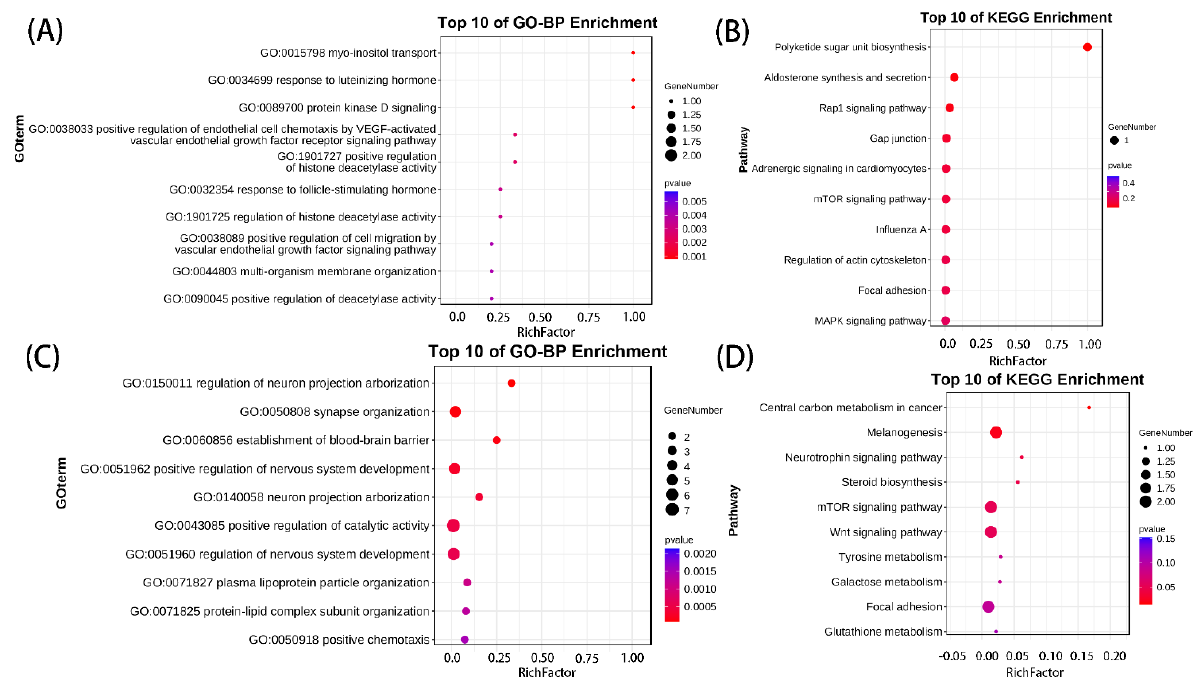
Figure 4. Functional enrichment analysis on DEcirc/miRNAs-DEmRNAs overlapping genes: ( A , B ) the top 10 GO-BP and KEGG enrichment analyses of DEcircRNAs–DEmRNAs overlapping genes; ( C , D ) the top 10 GO-BP and KEGG enrichment analyses of DEmiRNAs–DEmRNAs overlapping genes.